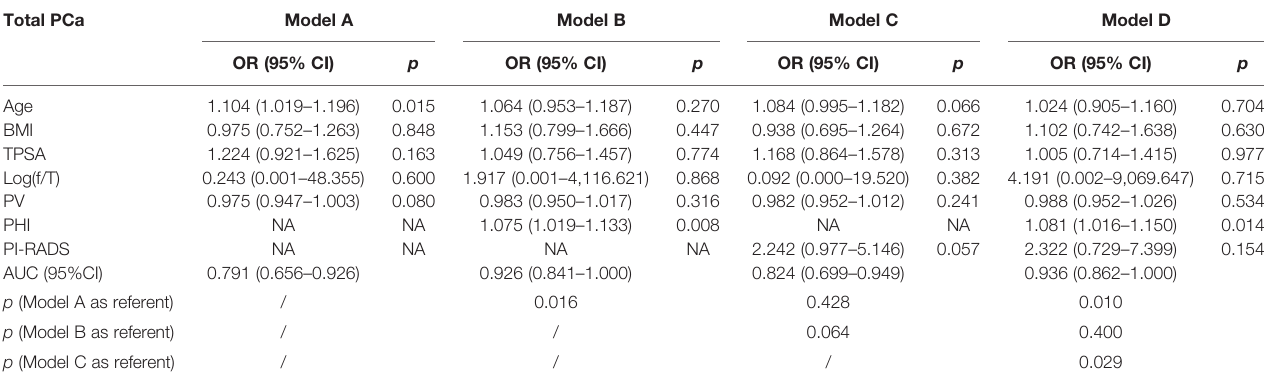
TABLE 4A | Multivariable analysis of the predictive value of the different models in the diagnosis of PCa in the PSA 10 – 20 ng/ml.